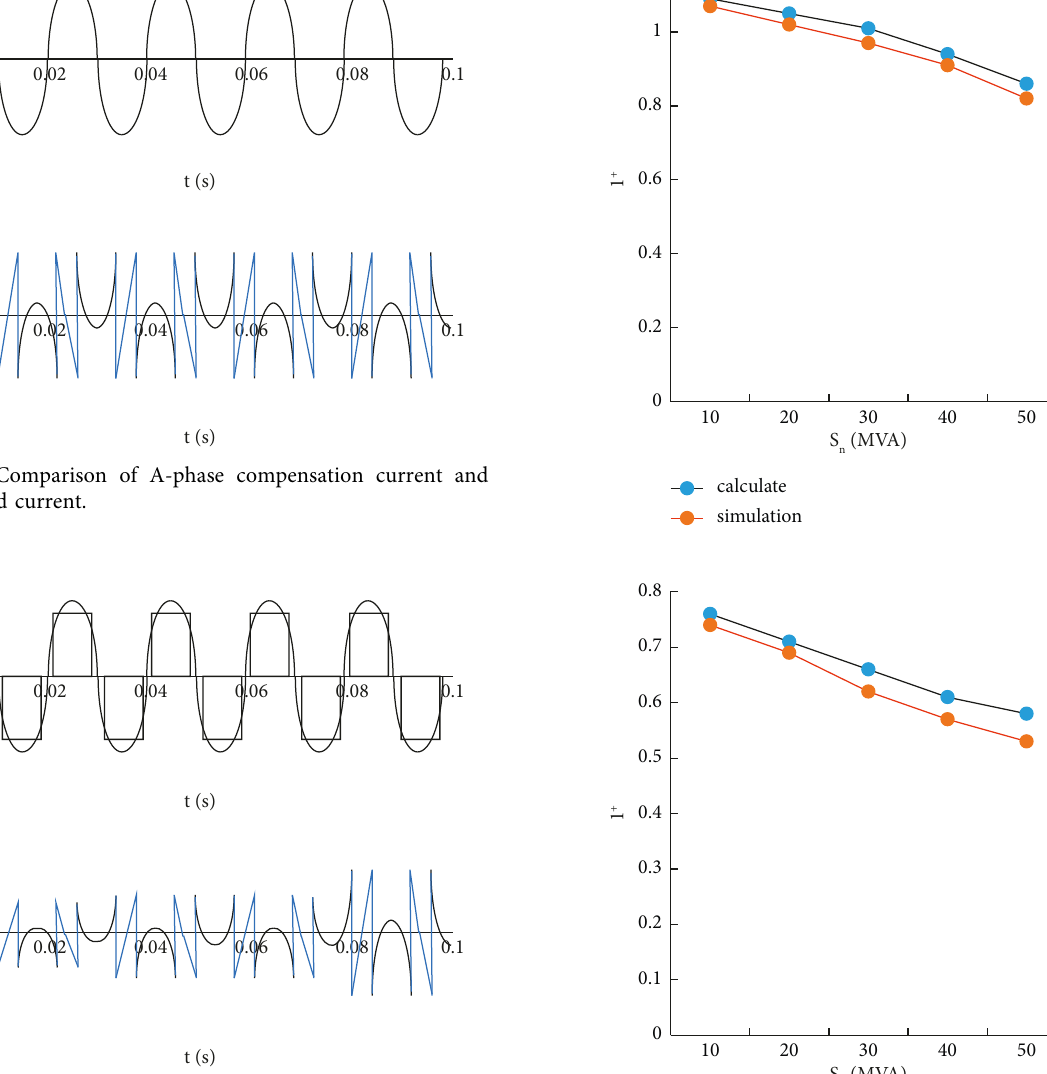
Figure 9: A-phase compensation current and compensated load current.